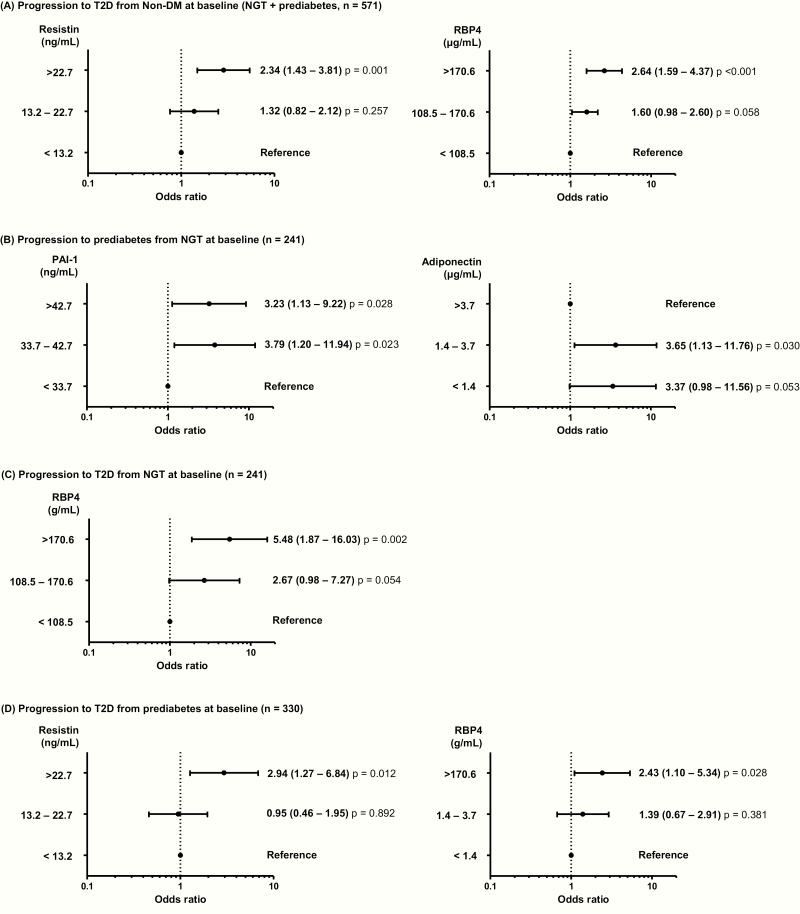
Progression to prediabetes and type 2 diabetes. (A) Risk factors for the progression to type 2 diabetes at the 10-year follow-up examination in participants with normal glucose tolerance (NGT) or prediabetes (n = 571). (B) Risk factors for the progression to prediabetes at the 10-year follow-up examination in participants with NGT (n = 241). (C) Risk factors for the progression to type 2 diabetes at the 10-year follow-up examination in participants with NGT (n = 241). D: Risk factors for the progression to type 2 diabetes at the 10-year follow-up examination in participants with prediabetes (n = 330). Multinomial logistic regression model was used after adjustment for age, sex, waist circumference, systolic blood pressure, and concentrations of fasting plasma glucose, alanine aminotransferase, and C-reactive protein. The levels of cytokines are expressed as tertiles, and odds ratios (95% CIs) are shown above the black circle.